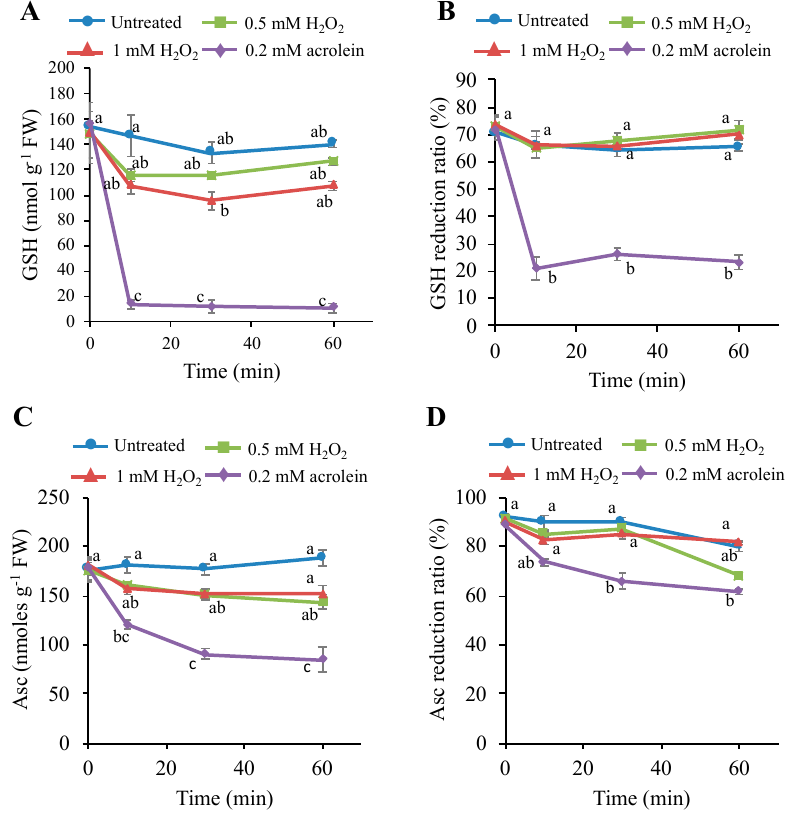
Figure 6. Changes in the contents and reduction ratios of ascorbate (Asc) and glutathione (GSH) in tobacco BY-2 cells treated with H 2 O 2 or acrolein. H 2 O 2 and acrolein at the indicated concentration was added to 4-d cultured cells, and then Asc and GSH contents were measured as described in the Materials and Methods section. ( A ) Reduced Asc, ( B ) Asc reduction ratio (%), ( C ) contents of reduced GSH, and ( D ) GSH reduction ratio (%). Each point represents the mean of three independent experiments and the error bars of the SEM. Different letters represent significant different data ( p < 0.05 on Tukey test).